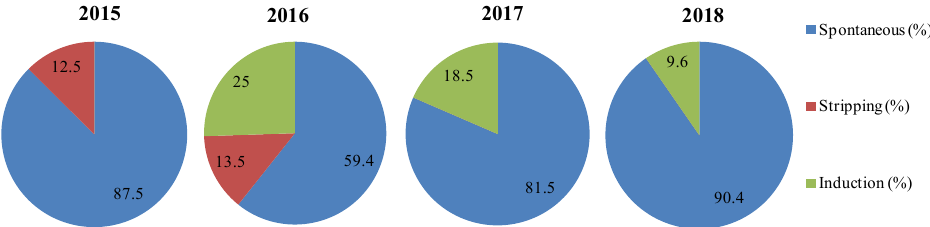
Figure 5. Percentage of spontaneous, artificial (by stripping), and GnRHa-induced spawns during 2015–2018 in the three Galician wreckfish broodstock.